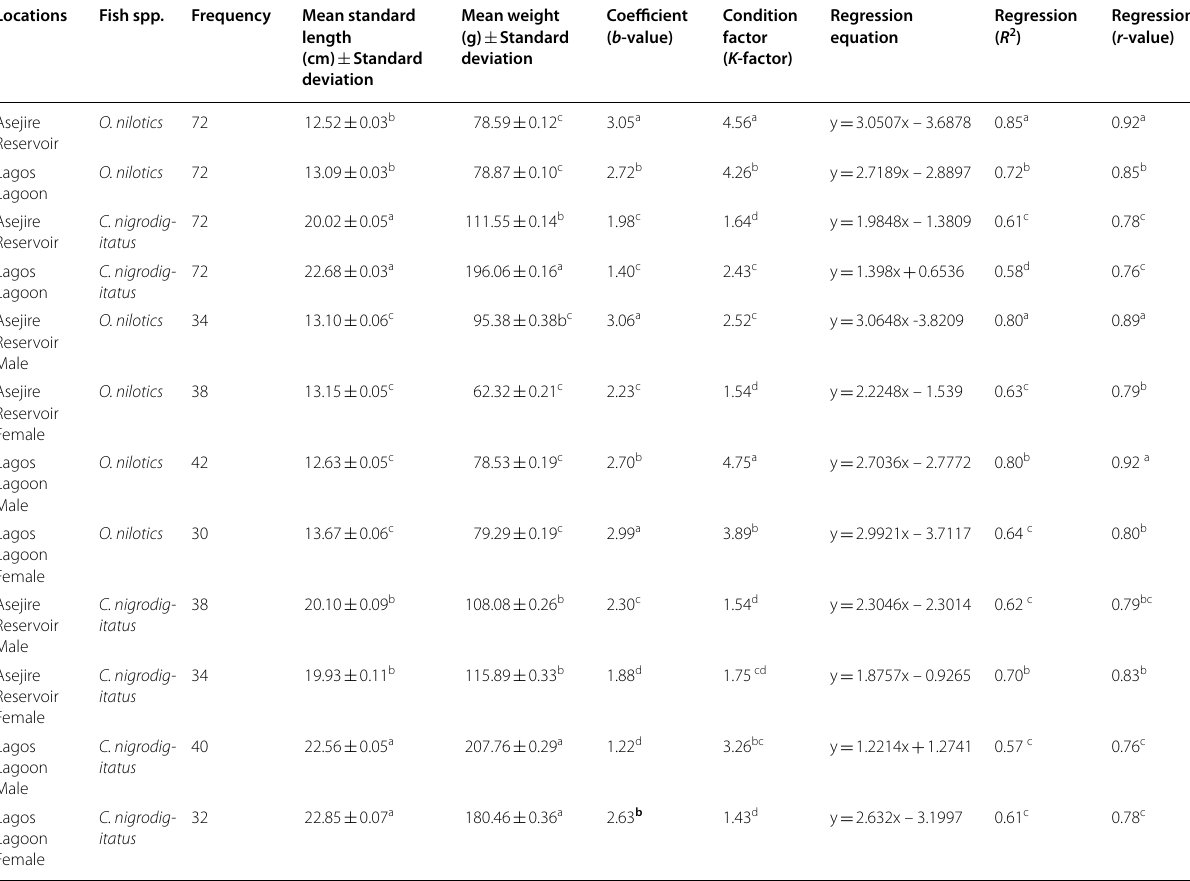
Means with the same superscripts along the column are not significantly different, ( P >